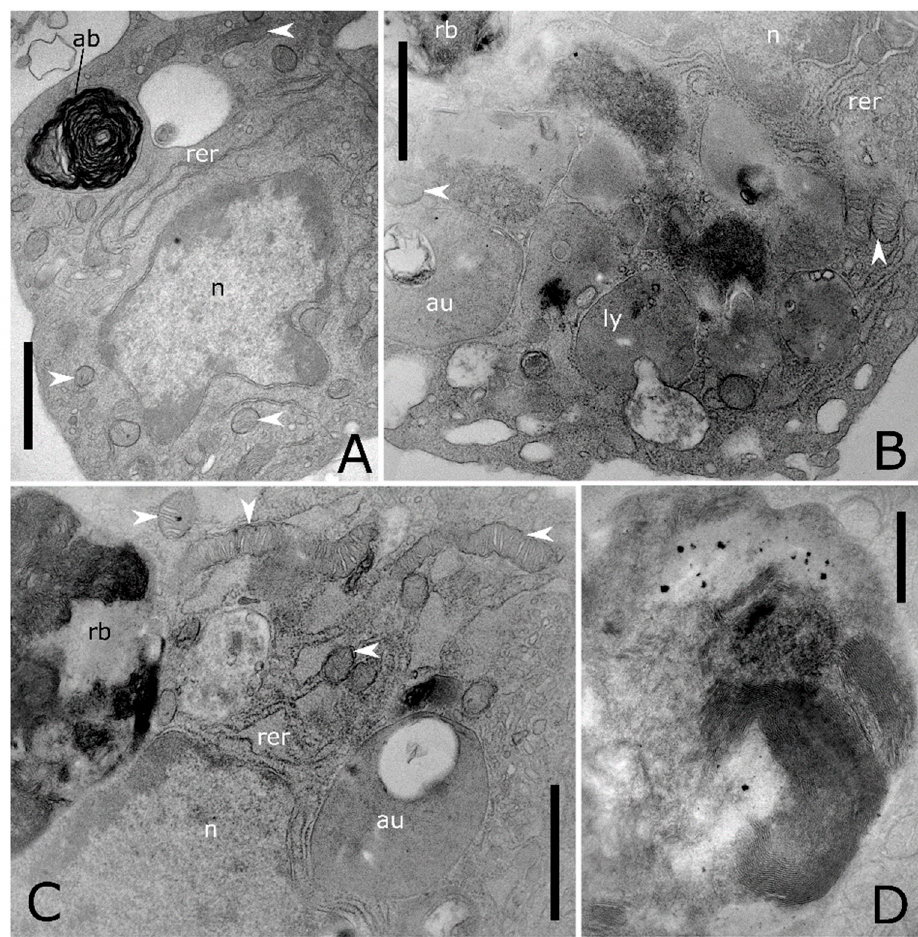
Figure 6. Ultrastructure of autophagic processes in T. molitor haemocytes. ( A ) Cytoplasm showing an autophagic body (ab) with electron dense myelinic figures inside. ( B ) Magnification of the cytoplasm showing lysosome (ly) at different stages of maturation, fusing with phagosome, featured by electron lucent appearance and storing amorphous content. ( C ) Residual body (rb) storing packed membranes and an autolysosome (au). ( D ) Detail of a residual body, electron dense content with evident myelinic figures. n: nucleus, rer: rough endoplasmic reticulum, white arrowheads: mitochondria. Bars: 1 µ m ( A – C ); 500 nm ( D ).